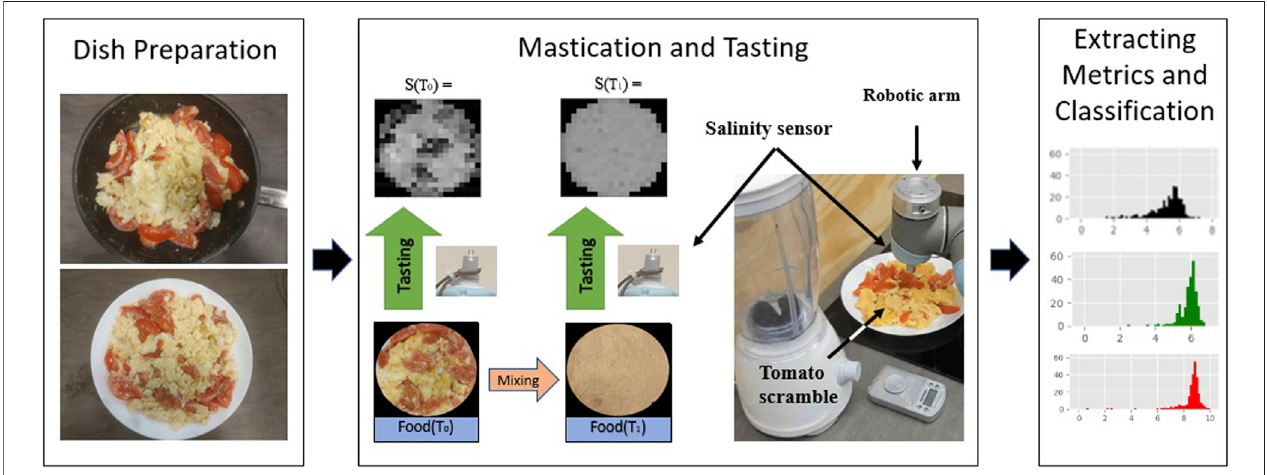
FIGURE1| Experimentoverview.Ninedishesispreparedforrobotictasting.Eachofthedishesistastedbytherobotbeforeandaftermixing.Asetoftastemetrics is then extracted from each tasting and used to train a test SVM classi fi er.